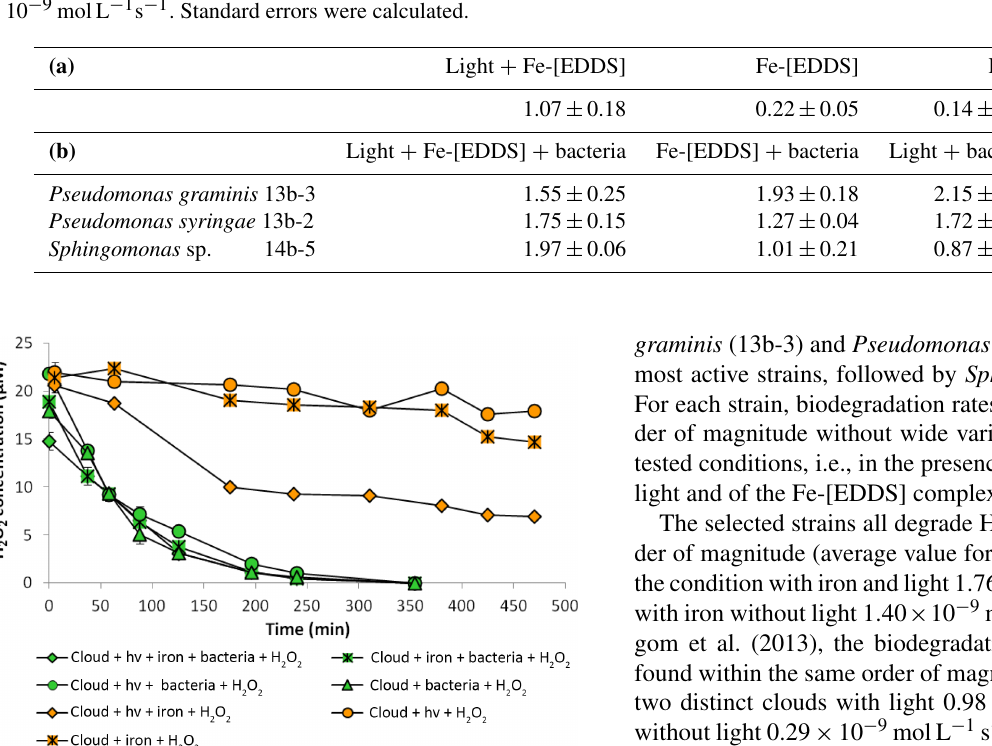
Table 1. Initial rates of abiotic degradation (a) and biotic degradation (b) of H 2 O 2 measured in artificial cloud water. Values are expressed in 10 − 9 molL − 1 s − 1 . Standard errors were calculated.